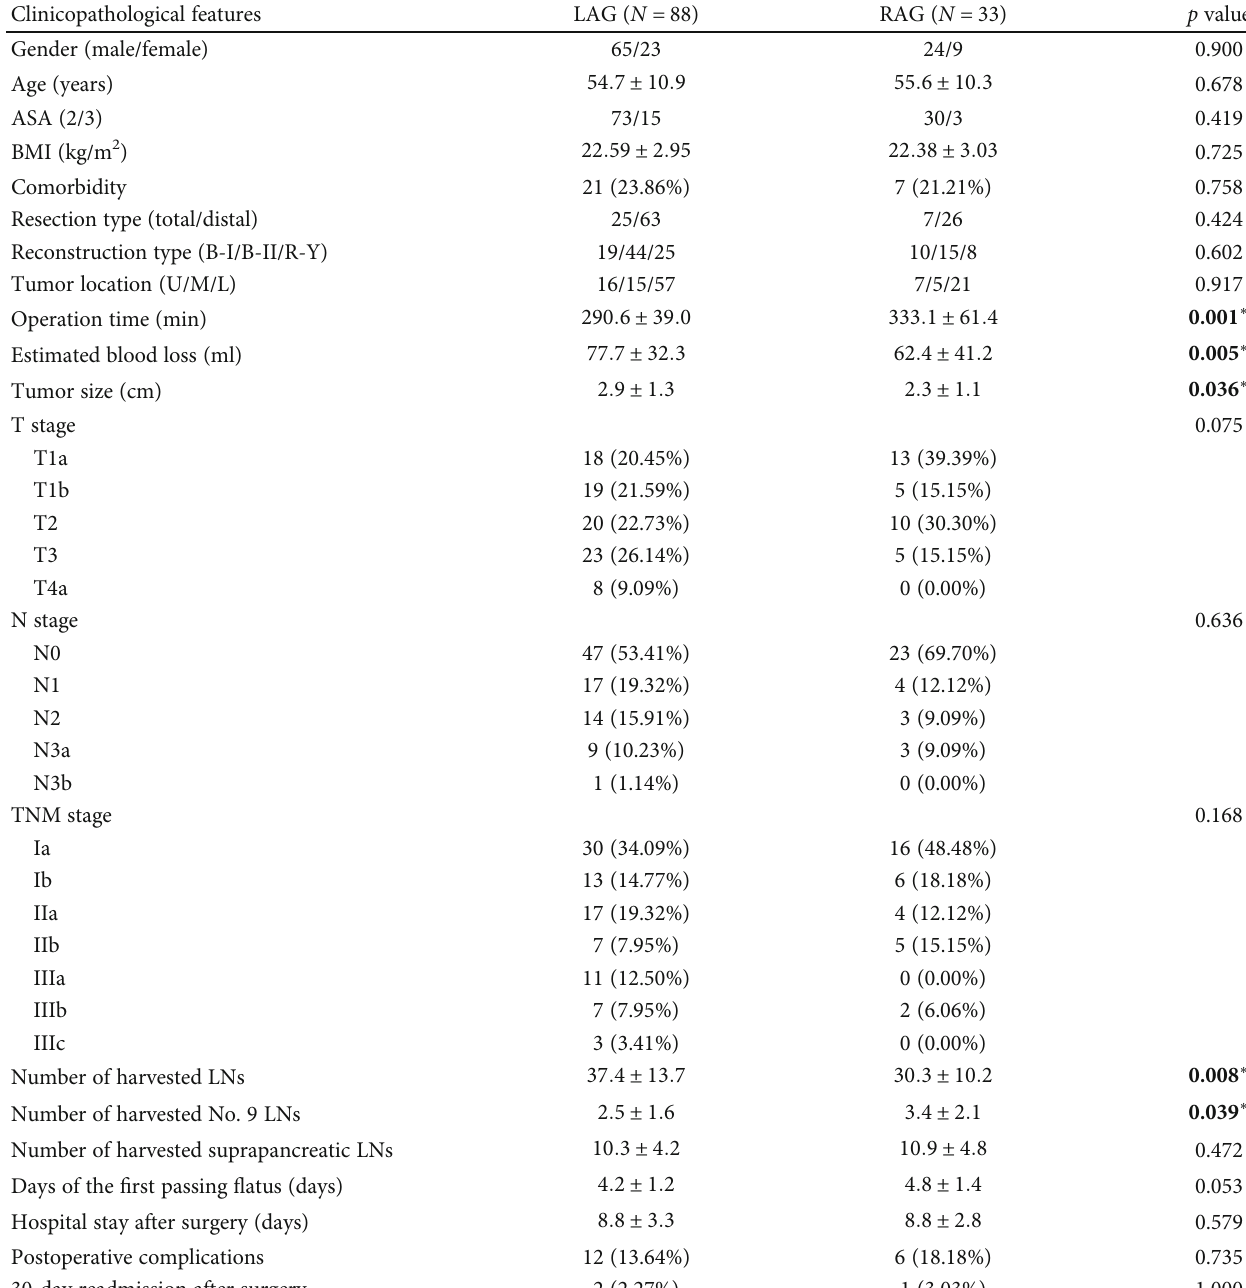
Table 1: Clinicopathological characteristics of all